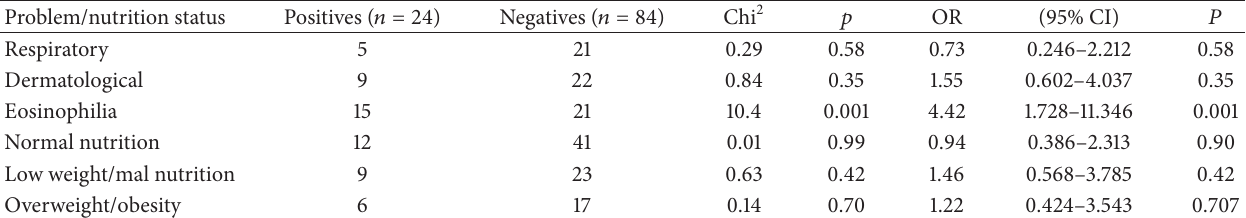
Table 2: Health problems and nutritional status associated with toxocariasis serology in children from Ecatepec, Mexico.